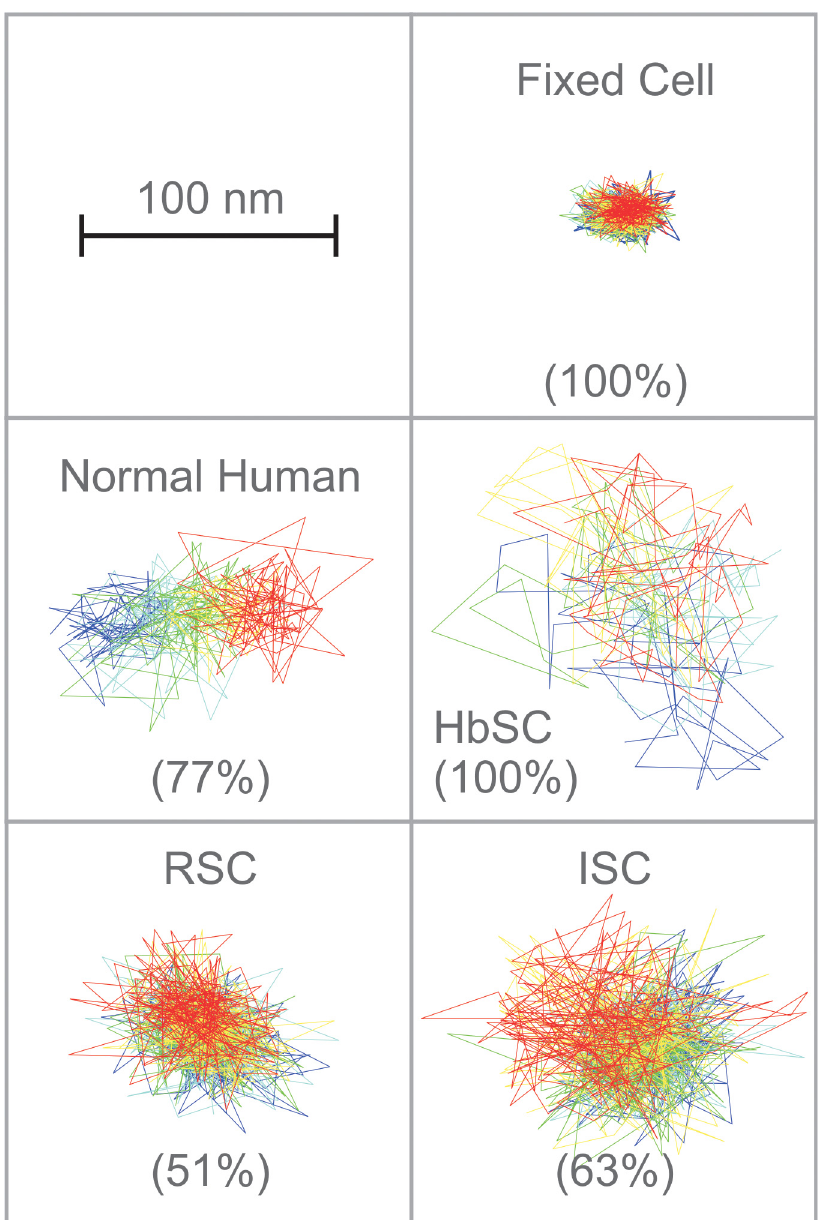
Fig 2. Representative trajectories of DIDS-biotin labeled band 3 on intact normal and sickle human erythrocytes. After labeling with DIDS-biotin conjugate, the diffusion of the labeled band 3 was imaged for 100 consecutive frames at 120 frames/sec on intact fixed normal red blood cells, unfixed normal erythrocytes, HbSC erythrocytes, reversibly sickled cells (RSC) or irreversibly sickled cells (ISC). The different colors track band 3 diffusion as a function of time, beginning with blue and progressing through the colors of the rainbow to red. Because all of these erythrocytes have multiple subpopulations of band 3, the trajectory of only the most abundant population is displayed (% of total band 3 is indicated in